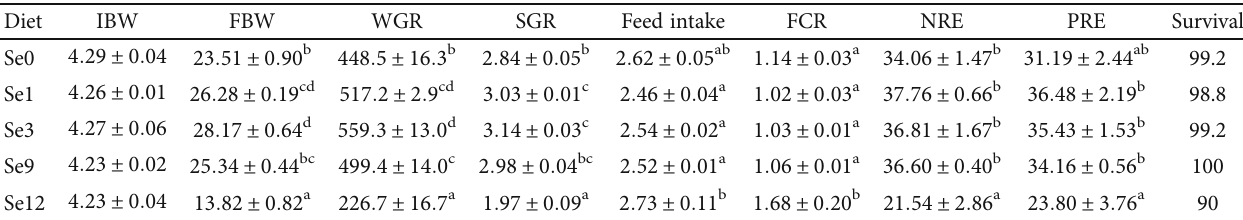
Table 2: Initial body weight (IBW, g/ fi sh), fi nal body weight (FBW, g/ fi sh), weight gain rate (WGR, %), special growth rate (SGR, %/d), feed intake, feed conversion rate (FCR), nitrogen retention e ffi ciency (NRE, %), phosphorus retention e ffi ciency (PRE, %), and survival rate (%) of juvenile triangular bream ( Megalobrama terminalis ) fed the test diets.